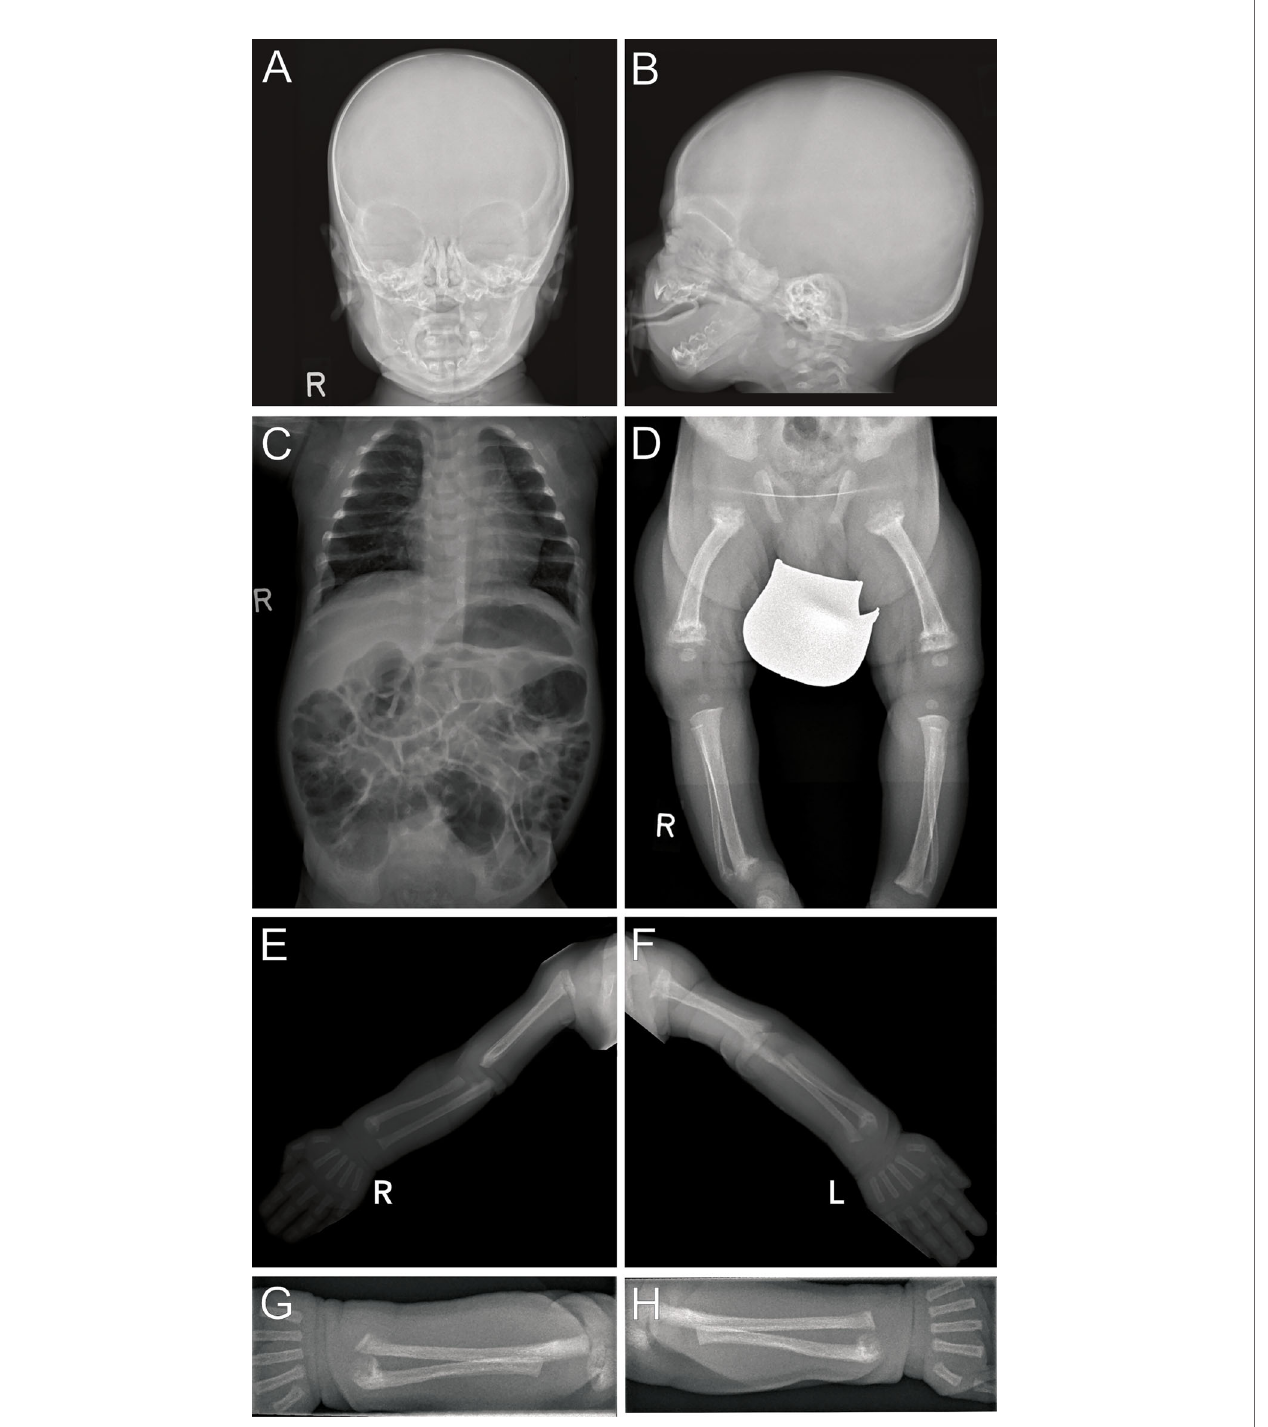
FIGURE 2 | Radiographs (Patient 2) at 3 weeks of life: Images of the skull (A, B) show blurred borders at the cortical/medullar bones and wide sutures with occipital intrasutural bones (Wormian bones). Poor mineralization is present in the skeleton as seen on the thoracoabdominal radiograph (C) arms and legs. Multiple metaphyseal fractures are present in both arms, with malalignments of the radius and ulna (E – H) . Distal fractures of the right tibia and fi bula are present (D) , with internally rotated position and, to a lesser extent, likewise on the left. Fractures on the left side are close to consolidation, indicating intra uterine onset of